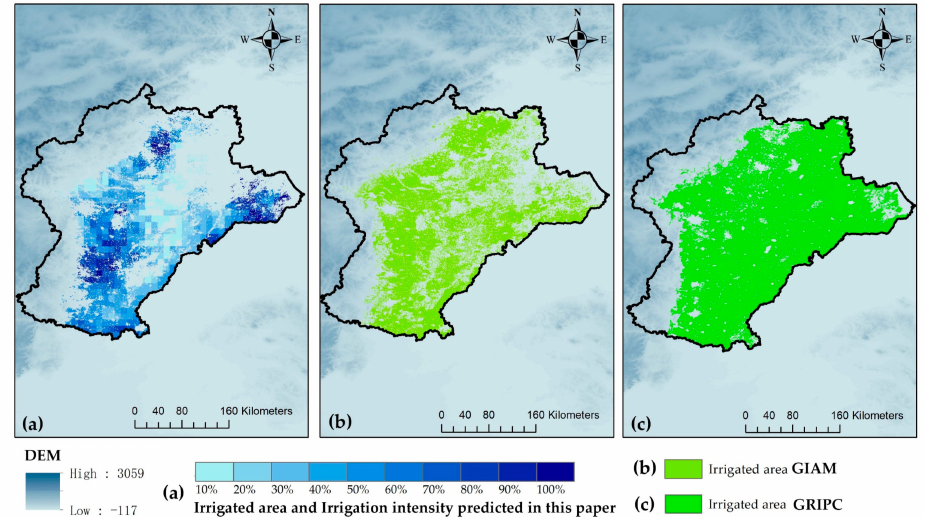
Figure 9. Irrigated area distribution in the study area. ( a ) shows the downscaled irrigated area and irrigation intensity results, ( b ) shows the irrigated area from GIAM, and ( c ) shows the irrigated area from